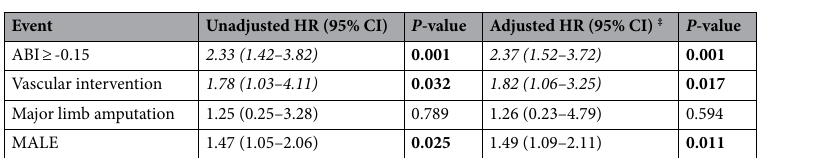
Table 4. Cox regression models for adverse events in PAD patients compared to non-PAD patients for one unit increase of log (uNGAL/uCr). ‡ Adjusted for age, sex, eGFR, hypertension, hypercholesteremia, smoking, diabetes, history of CAD. All p -values were rounded to three decimal places, P < 0.05 in bold. ABI: Ankle Brachial Index; MALE—defined as vascular intervention or limb loss. Significant values are in